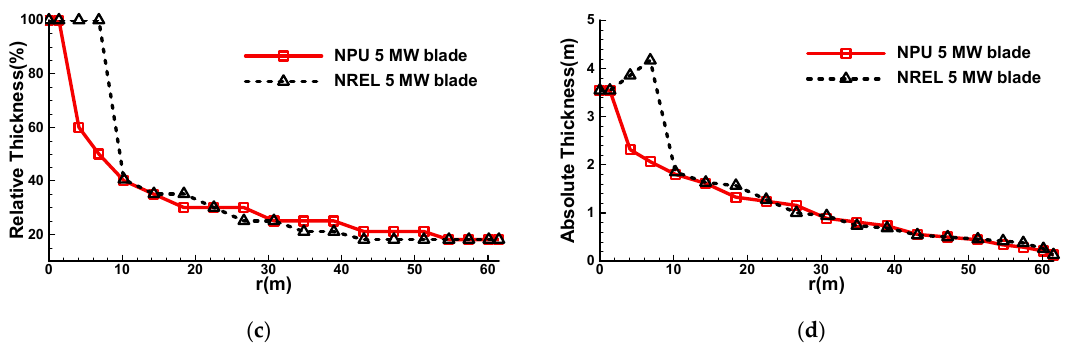
Figure 20. Comparison of geometric parameters between the NPU 5 MW blade and NREL 5 MW blade: ( a ) chord length distribution; ( b ) twist angle distribution; ( c ) relative thickness distribution; ( d ) absolute thickness distribution.